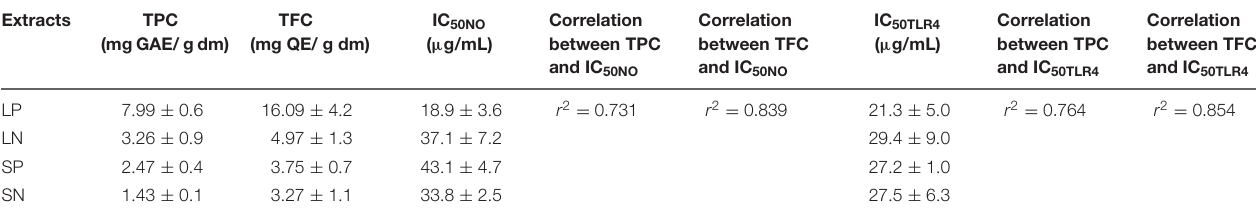
TABLE 1 | Correlation between TPC and TFC of extracts and its IC 50 values in Griess (IC 50 NO ) and TLR-4 activation assay (IC 50TLR4 ). Extracts IC 50NO ( μ